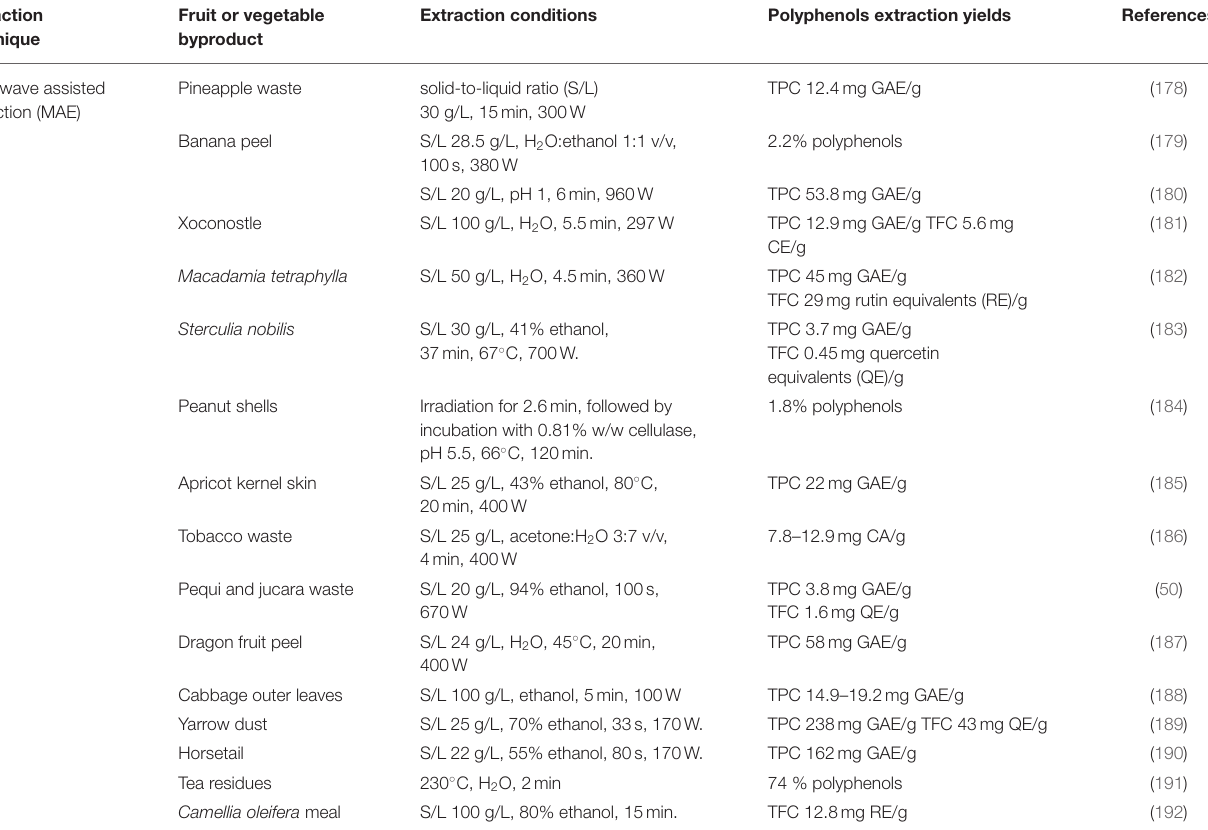
TABLE 1 | MAE extraction of phenolic compounds from various agri-food wastes. Extraction